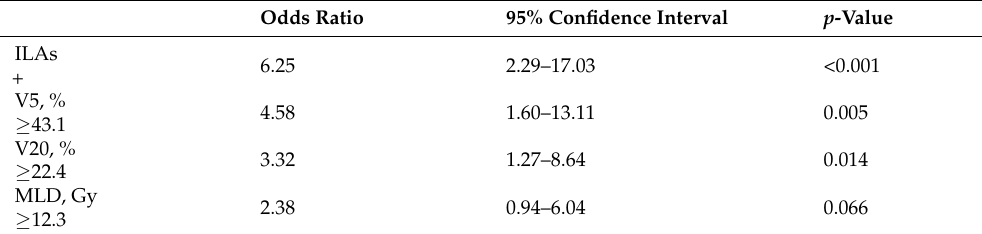
Table 6. Univariate logistic regression analysis of risk factors for early onset grade ≥ 2 ILD.